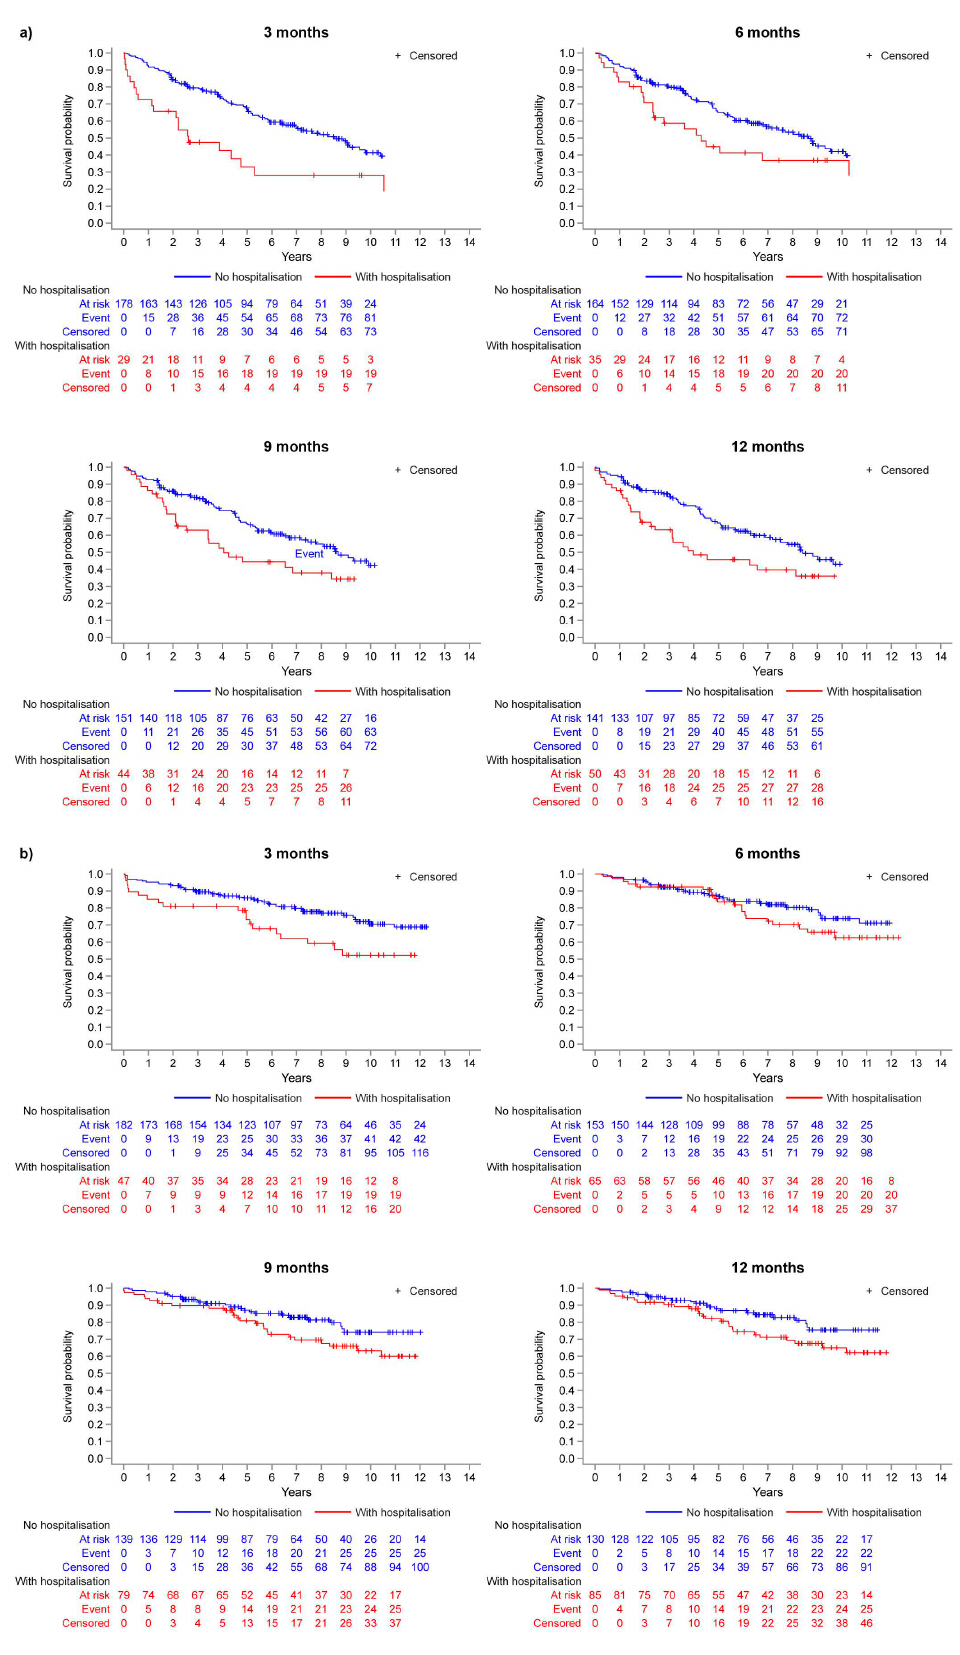
Figure 2. Kaplan–Meier analysis: survival probability at each landmark timepoint (model M1) for ( a ) inoperable patients and ( b ) operable